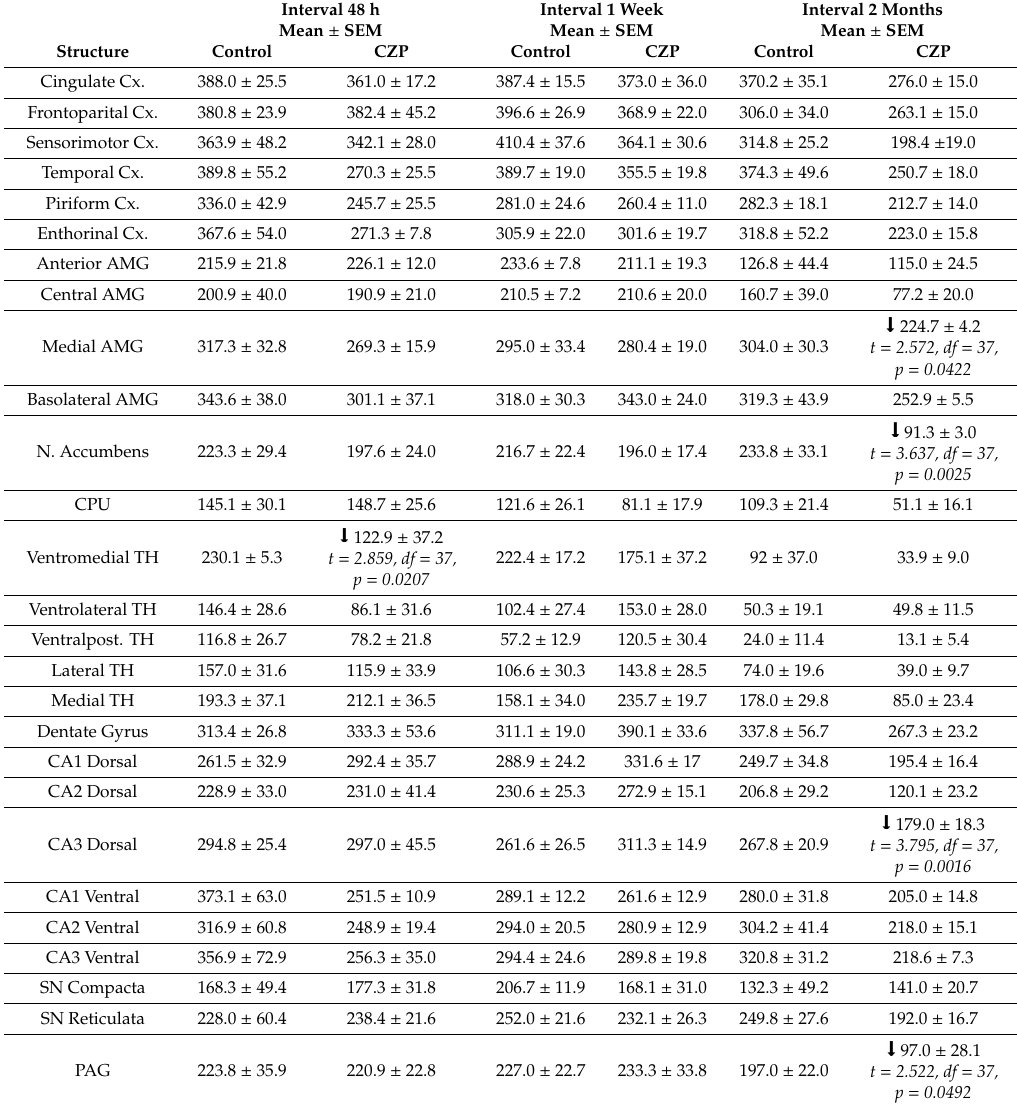
Table A3 demonstrates [3H] flunitrazepam binding to BZD receptors expressed in fmol / mg of protein in the brain areas (abbreviations as in Table A1) of control and clonazapam-treated rats. All details as in Tables A1 and A2. Table A3. [3H] flunitrazepam binding to BZD receptors.